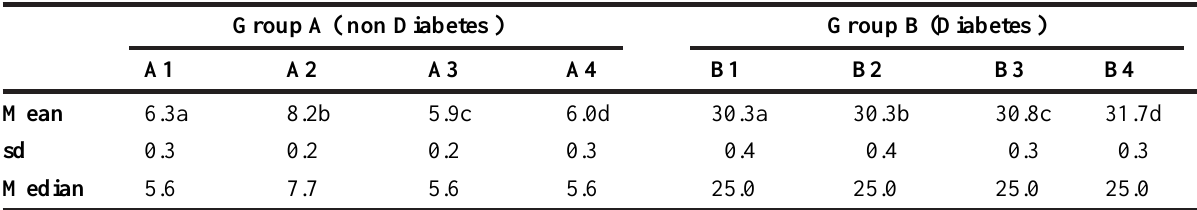
TABLE 1 - Distribution of the microalbuminuria values (µg/L) in 24 hours urine, just before the first ESW. Values are given as mean ± sd and median